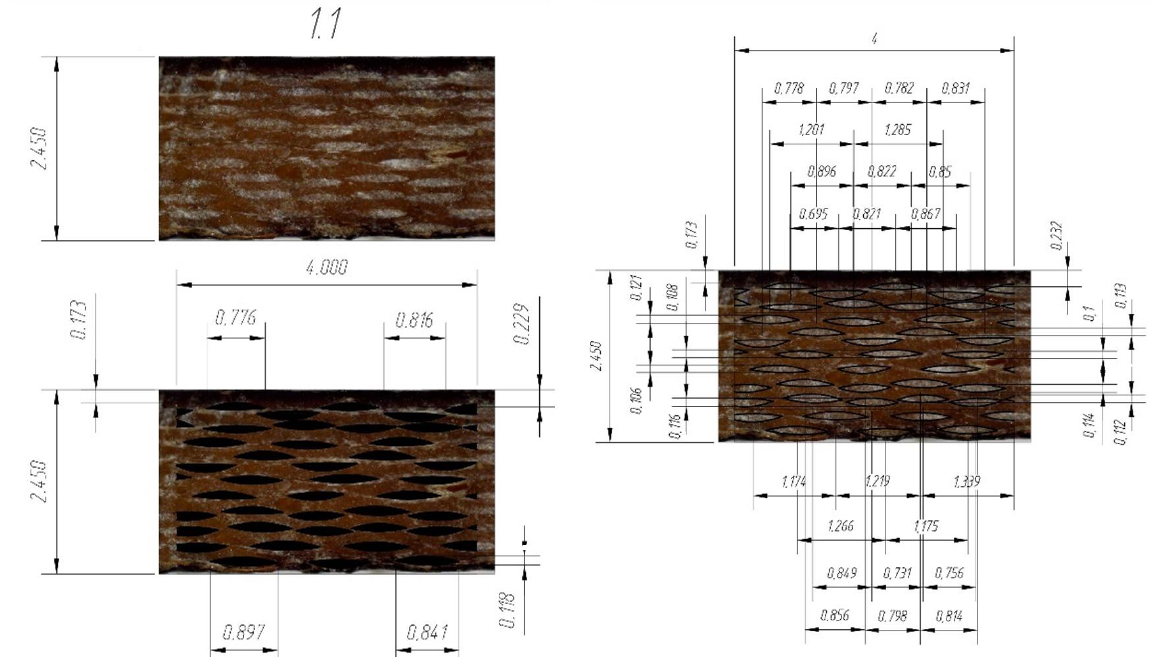
Figure 6. Microphotograph of a fragment of the sample cross-section: (1) highlighted “gross” area of the longitudinal yarn; (2) approximate distribution of fibers inside the yarn.